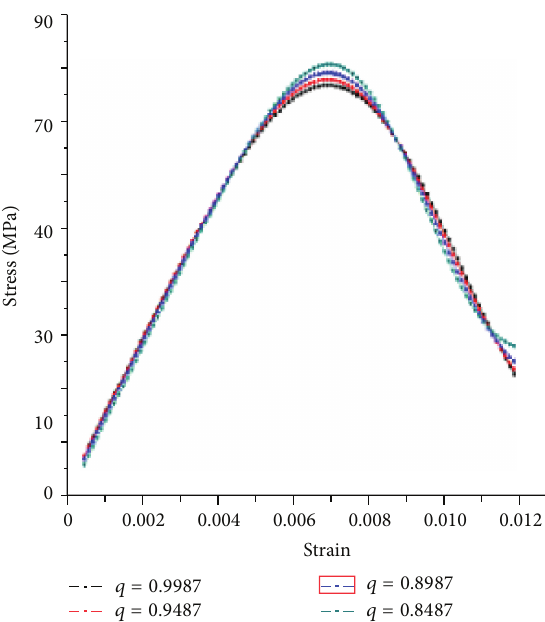
Figure 4: The effect of parameter 𝑚 on constitutive curve.